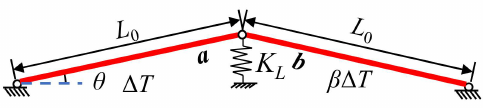
Figure 1. Schematic diagram of the temperature change in the two-pole structure.